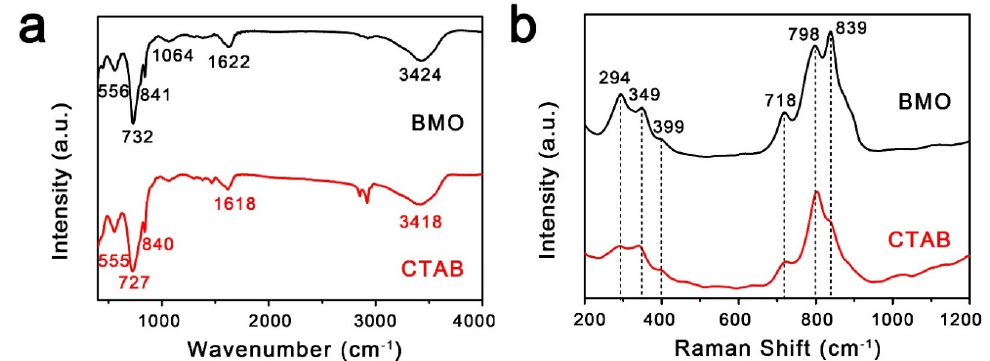
Figure 5. Fourier transform infrared spectra ( a ) and Raman spectra ( b ) of BMO and BMO-CTAB.